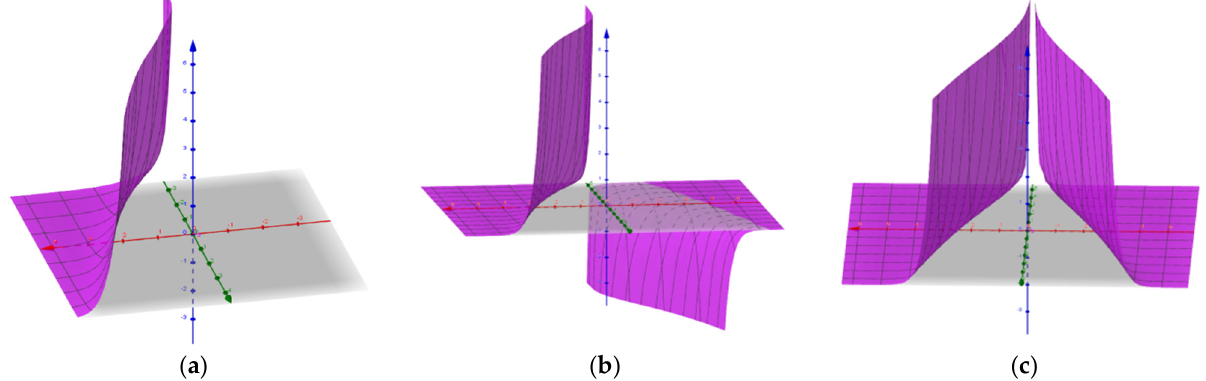
Figure 4. For the three soliton-like solution u 3 ( x , t ) , when f ( t ) = t , k 1 = 1, k 2 = 3, k 3 = 2, the corresponding graphs of m = 1, m = 2 and m = 4 are given as above. ( a ) f ( t ) = t , k 1 = 1, k 2 = 3, k 3 = 2, m = 1; ( b ) f ( t ) = t , k 1 = 1, k 2 = 3, k 3 = 2, m = 2; ( c ) f ( t ) = t , k 1 = 1, k 2 = 3, k 3 = 2, m = 4.